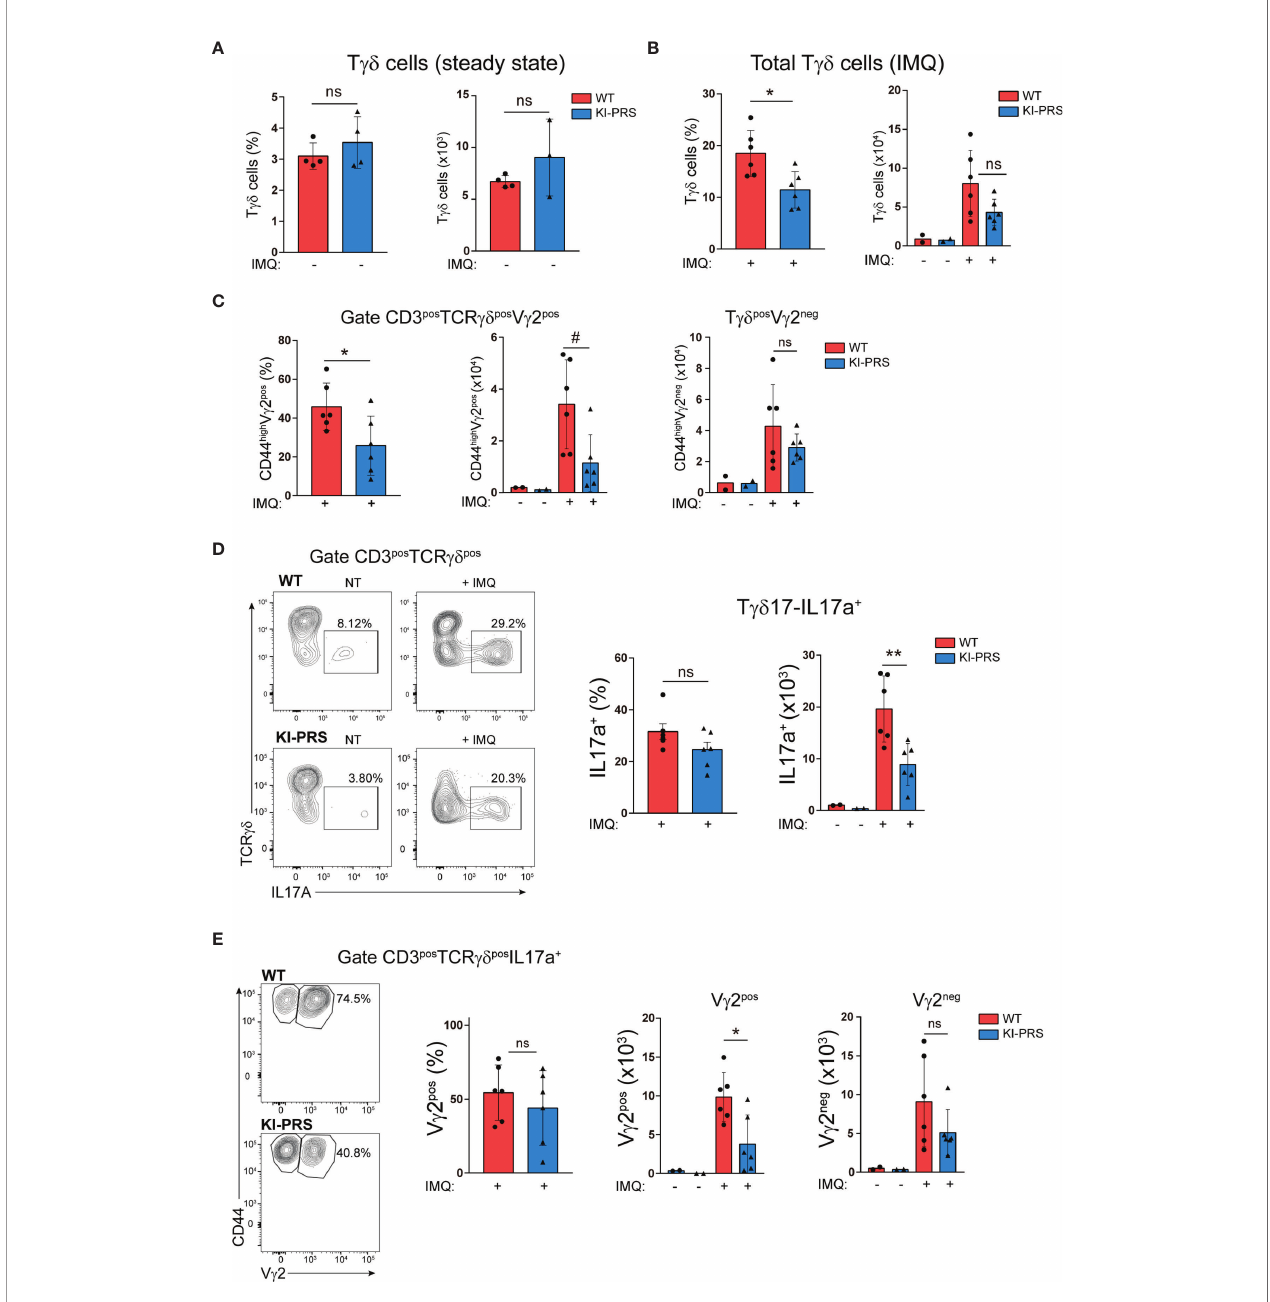
FIGURE 5 | Mutation of the CD3 e -PRS reduces IMQ-induced T gd skin in fi ltration. KI-PRS and WT littermates were treated with Imiquimod (IMQ) for 7 days on ears and shaved backs, or left untreated (NT). On day 7, ears were processed for the analysis of T gd in fi ltration by fl ow cytometry. (A) Graphs represent the frequency ( left ) and absolute cell number ( right ) of total T gd cells in the skin of untreated mice, gated as CD3 pos TCR gd pos . (B) Graphs represent the frequency ( left , *p-value= 0.0152) and absolute cell number ( right graph ) of total T gd cells in the in fl amed skin, gated as CD3 pos TCR gd pos . (C) Graphs represent the frequency ( left , *p-value= 0.0411) and absolute cell number ( right , # p-value= 0.0152) of V g 2 pos and V g 2 neg cells among total T gd cells, gated as CD3 pos TCR gd pos . (D) Analysis of IL-17A production. Cell suspensions obtained from in fl amed and non-treated skin were stimulated with PDBu/Io for 4h in presence of Golgi-Plug, and IL-17A production was determined by fl ow cytometry. Representative dot plots show IL-17A production among T gd cells (gated as CD3 pos TCR gd pos ), and inset numbers represent the percentage of IL-17A+ cells. Graphs show the frequency ( left ) and absolute cell number ( right , **p-value= 0.0043) of IL-17A-producers among T gd cells. (E) Representative dot plots show V g 2 expression among IL-17A-producing T gd cells (gated as TCR gd pos IL-17A+). Graphs represent the frequency ( left ) and absolute cell number ( right , *p-value= 0.0260) of V g 2 pos and V g 2 neg cells among IL-17A-producing T gd cells. All graphs represent mean ± sd of n=6 mice of each genotype. Statistical analysis was performed using Mann-Whitney t-test. ns, non signi fi cant. Data are representative of 2 independent